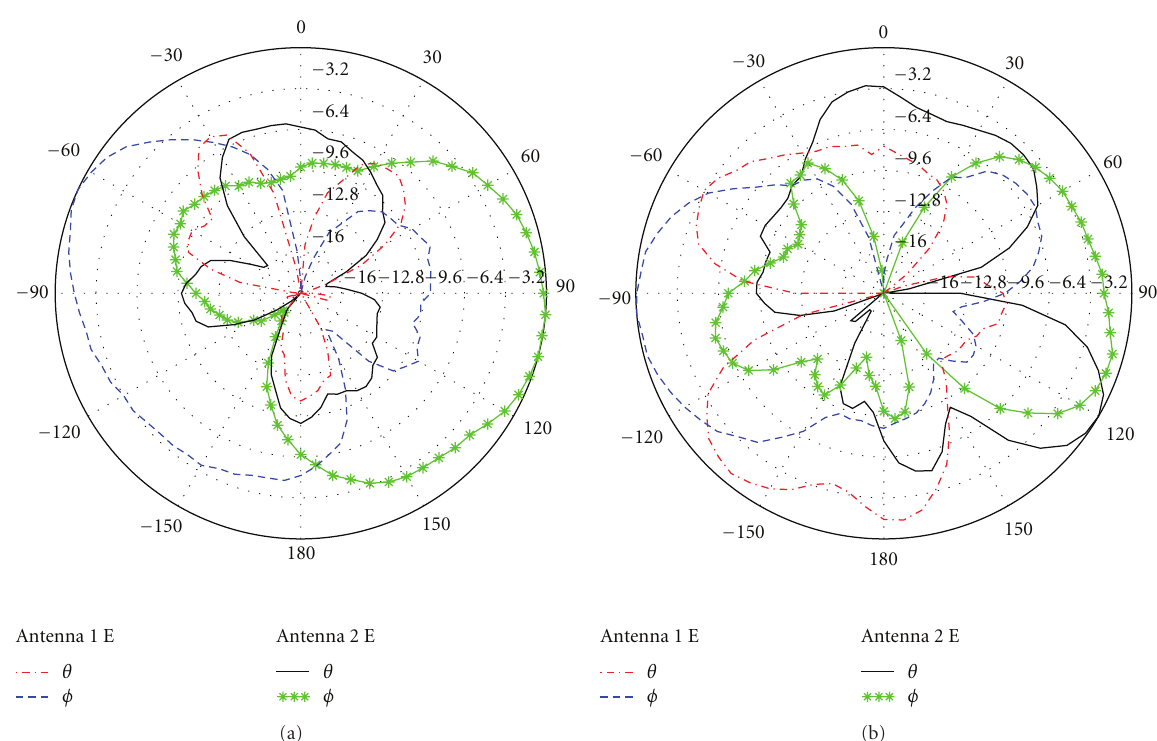
Figure 9: Measured radiation pattern at 1.9GHz. (a) The yoz plane. (b) The xoz